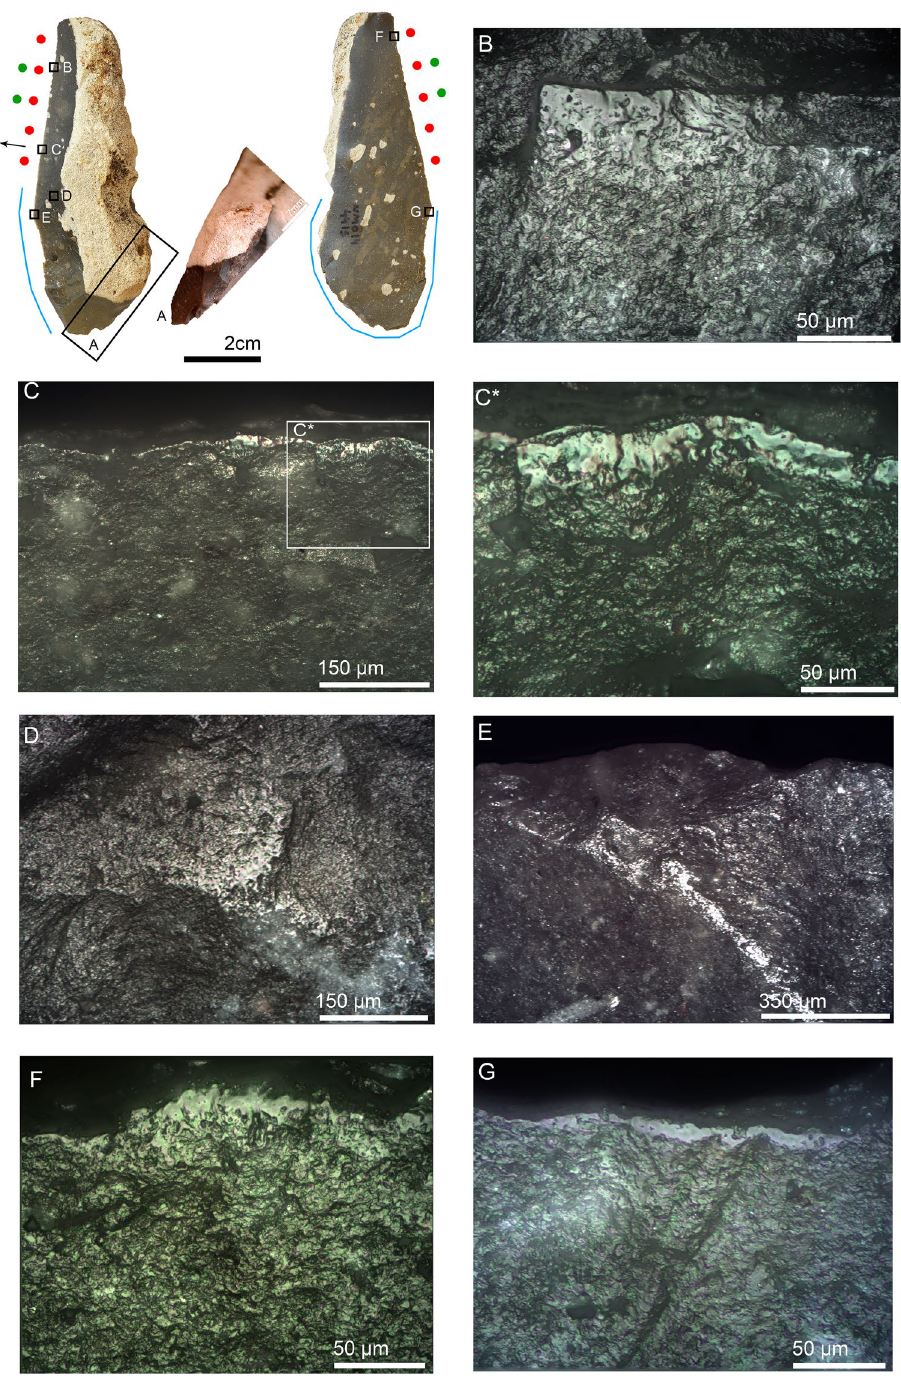
Figure 6. Naturally backed knife NMO14 4415 interpreted as a hafted wood-whittling knife. ( A ) abrupt retouch on the distal left edge, 10 ×; ( B ) smooth polish and transversal ripple on an elevated area between scars on the right proximal dorsal edge, 500 ×; ( C ) smooth-wavy polish and transversal ripples on the dorsal mesial right edge, 200 ×; ( C* ) close-up of the previous polish in which the smooth texture and wavy topography are appreciable, as well as transversal ripples indicating tool-use direction, 500 ×; ( D ) hafting polish on the mesial dorsal surface, 500 ×; ( E ) hafting scarring and hafting polish on the dorsal mesial ridge, 100 ×; ( F ) smooth polish with flat-wavy topography and transversal ripples on the ventral proximal right edge, 500 ×; ( G ) hafting bright spot on the ventral mesial right edge, 500 ×. *The tool is depicted upside-down to facilitate understanding of